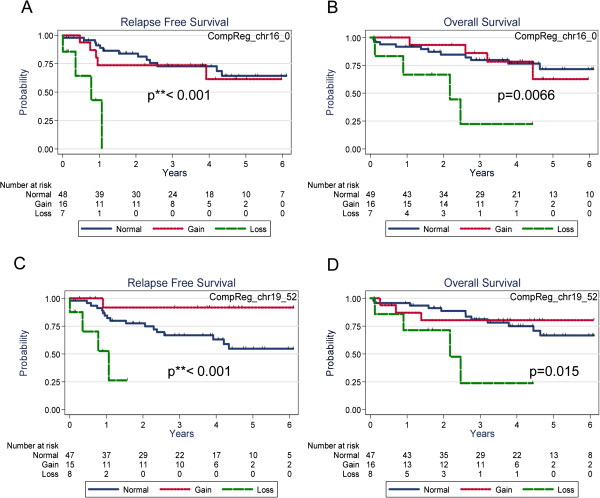
Relapse free and overall survival according to CNA at 16p13.3 and 19q13.3 in stage 2 and 3 CRCs. Losses at both locations are associated to shortened disease free and overall survival. Interestingly, gains at 19q13.3 appear to be protective for RFS. A: Relapse free survival according to CNA at 16p13.3. B: Overall survival according to CNA at 16p13.3. C: Relapse free survival according to CNA at 19q13.3. D: Overall survival according to CNA at 19q13.3. Red curves correspond to gain, green curves correspond to loss, and blue curves correspond to absence of CNA.